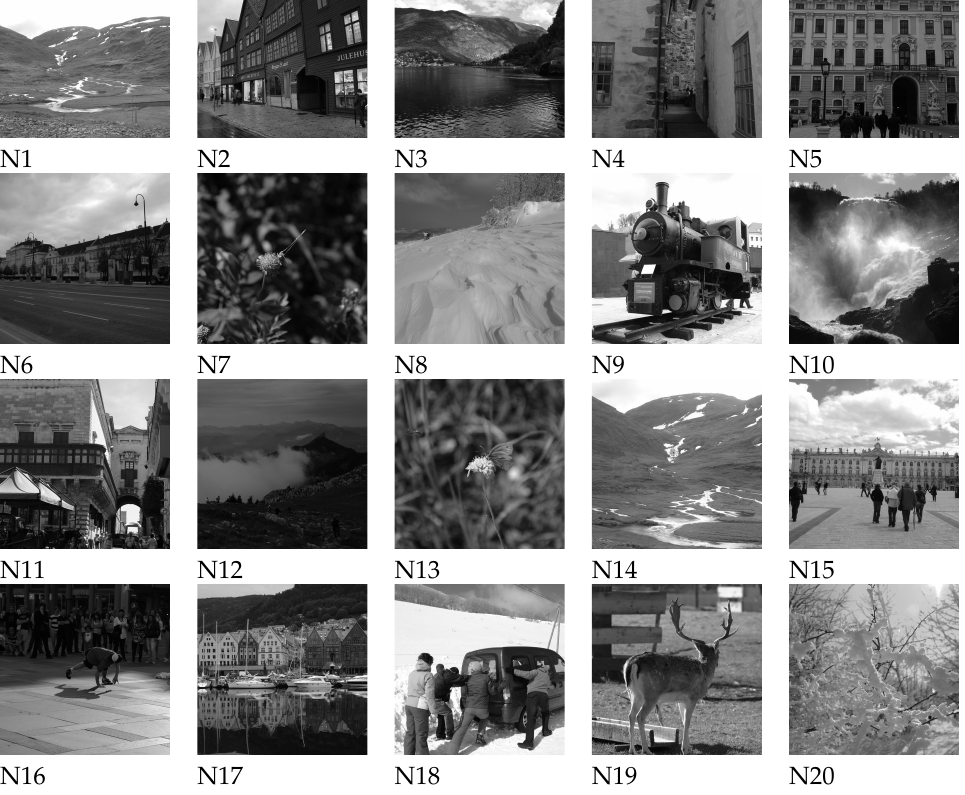
Figure A1. The test images (N1 to N20) utilized in the